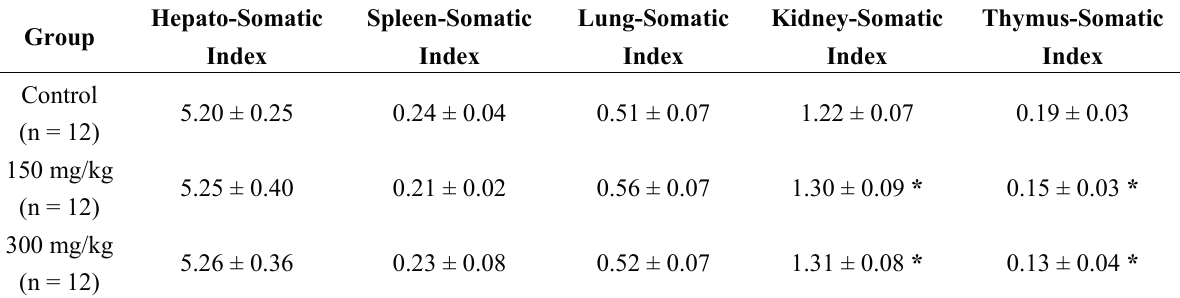
Table 1. Organ coefficient of benzene exposure groups (100×).